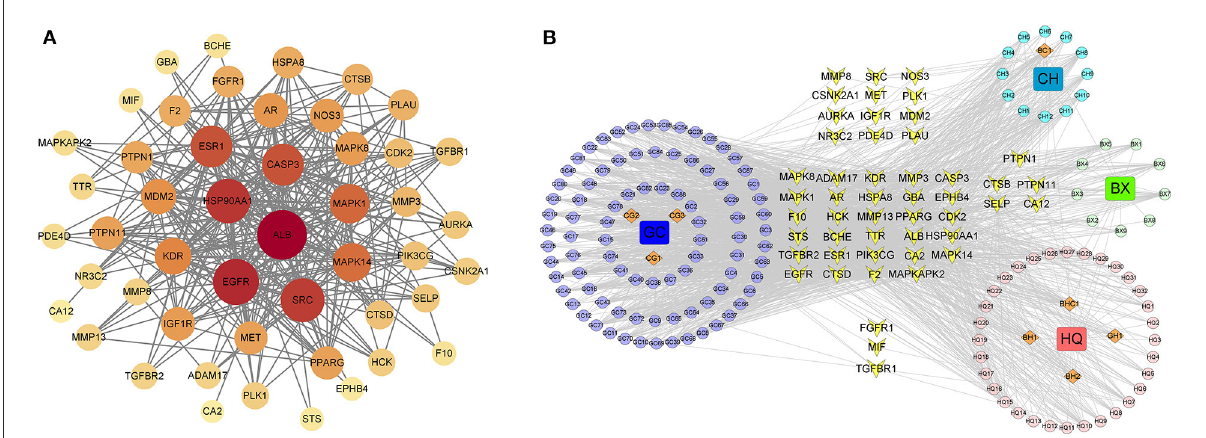
FIGURE5 (A) Protein–protein network (PPI) of anti-COVID-19 genes. (B) Drugs-ingredients-targets network. The four squares represent drugs, BX ( Scutellaria baicalensis ), GC ( Glycyrrhiza uralensis ), CH ( Bupleurum chinense ), and BX ( Pinellia ternata ). The circles indicate the corresponding ingredients, the orange diamonds indicate the shared ingredient, BH(BX,HQ), BHC(BX,HQ,CH), BC(BX,CH), CG(CH,GC), GH(GC,HQ), and the yellow quadrilaterals represent